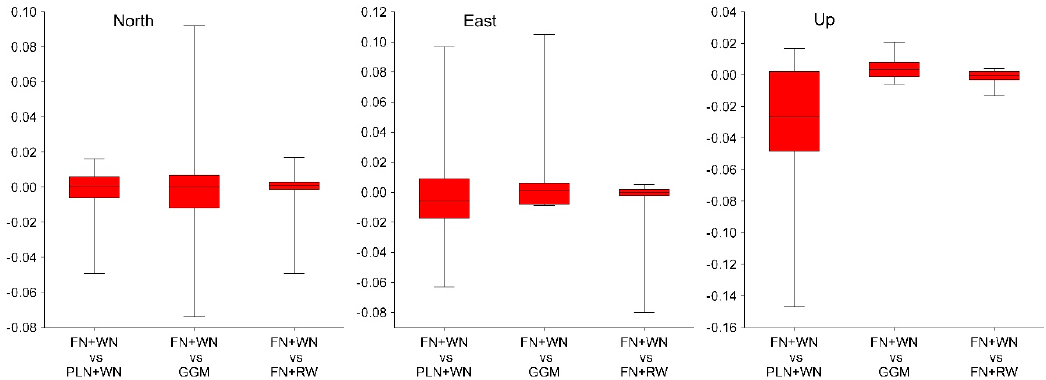
Figure 9. Velocity differences (mm/yr) of BERN_2 solution between selected noise models. The lines represent the median, the boxes represent 50% of the values, and the whiskers extend to the highest and lowest values (excluding outliers); the box length is the interquartile range.